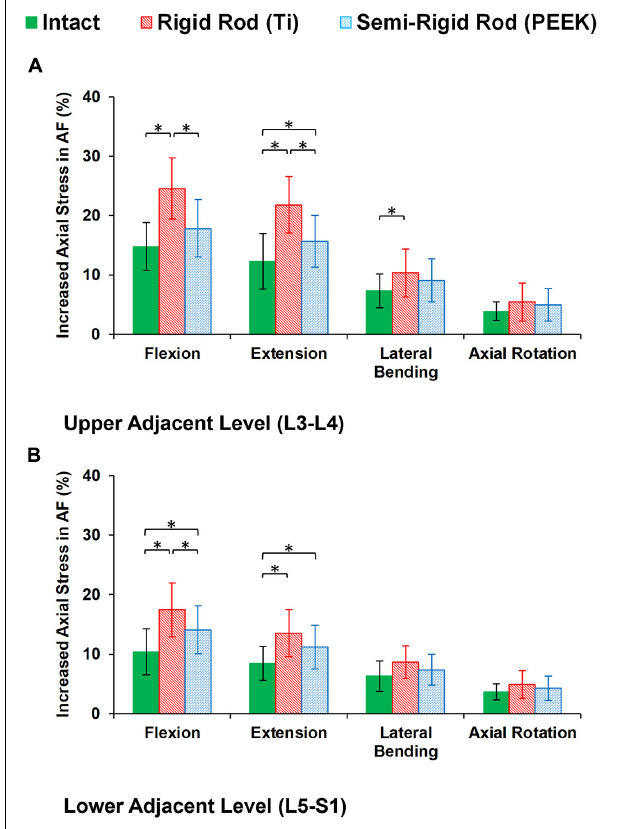
FIGURE 10 | Increased fiber strain in annulus fibrosus (AF) for postoperative FE models in the (A) upper adjacent level (L3–L4) and (B) lower adjacent level (L5–S1) in different directions. The reported results in lateral bending and axial rotation are the average in the left and right directions. The error bars indicate the standard deviations, and “ ∗ ” shows that p values <